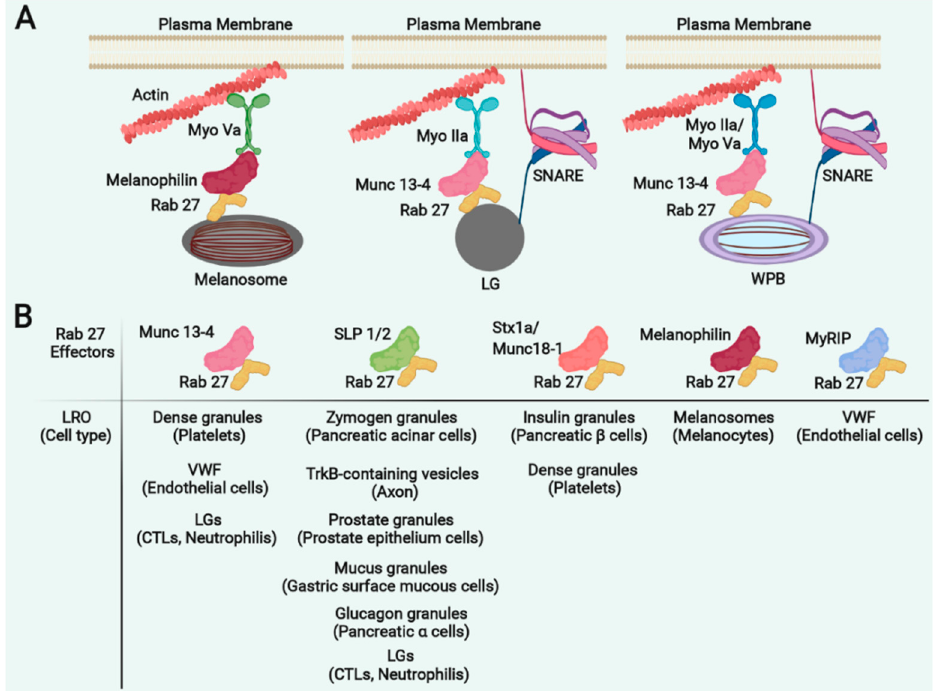
Figure 3. Common regulators of LRO trafficking in different cell types. ( A ). In melanocytes, Myosin Va(Myo Va) forms a complex with Rab27a and its effector Melanophilin, required to tether melanosomes to the actin cytoskeleton. In CTL and NK cells, Myosin IIa forms a complex with Rab27a and Munc13-4, which regulates the release of lytic granules. In endothelial cells, Mysin IIa (or MyosinVa) forms a complex with Rab27a and Munc13-4, which regulates the acute release of von-Willebrand factor from Weibel-Palade bodies (WPB). ( B ). Multiple effectors of Rab27a in different LROs of different cell types. Munc 13-4, mammalian uncoordinated 13-4; Slp, synaptotagmin-like protein; Stx1a, Syntaxin 1a; MyRIP, myosin VIIA and Rab interacting protein; TrkB, tropomyosin receptor kinase.